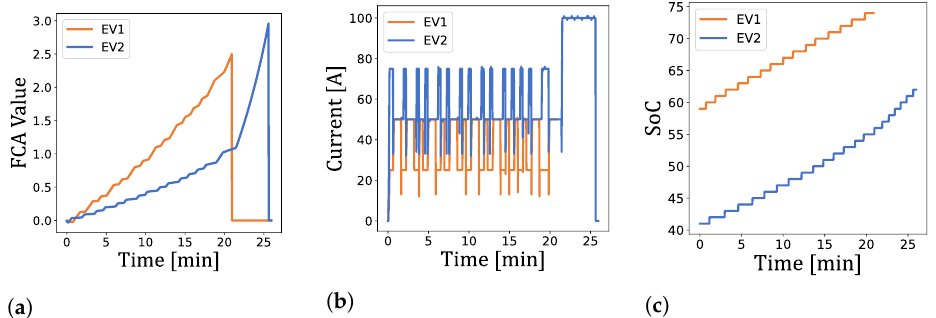
Figure 10. Measured Charging Process of Two Electric Vehicles Simultaneously. ( a ) Feeding Com- pensation Account, ( b ) Charge Power and ( c ) State of Charge.